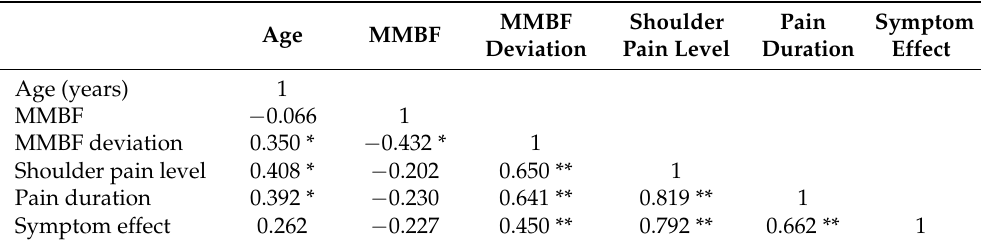
Table 2. Relationships between age, shoulder pain parameters, MMBF, and MMBF deviation for all participants ( n = 32) θ